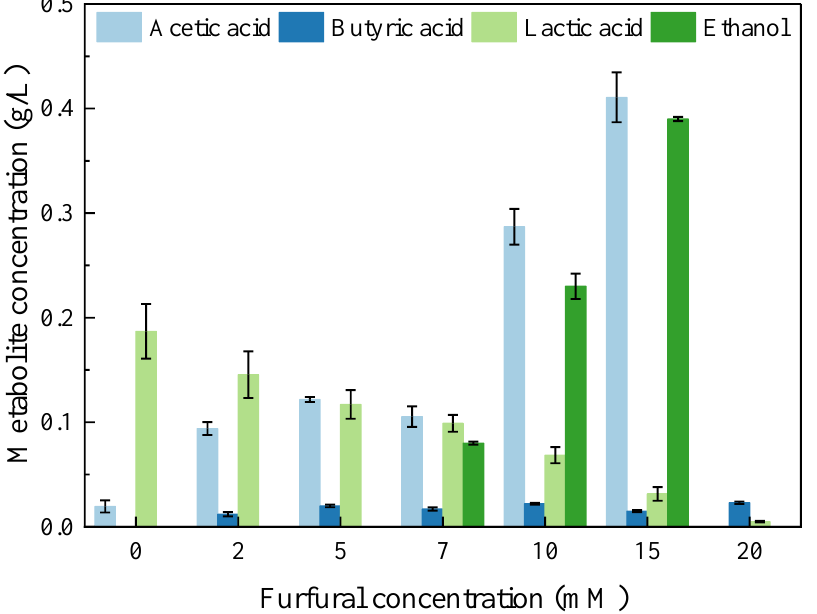
Figure 5. Effects of furfural concentration (0–20 mM) on the distribution of soluble metabolic products. Furfural can be decomposed into acetic acid in mixed anaerobic cultures, which may account for the increase in acetic acid [32]. Negligible butyric acid concentrations have been found at all furfural concentrations, including the control, and it is known that butyric acid is the substrate for hydrogen production. The above results suggested that butyric acid was formed by glucose degradation, which is reasonable, as few butyric acids were detected in the residual medium. Lactate was also found in all test conditions but showed the highest concentration at 0 mM furfural and the least at 20 mM furfural. In addition, ethanol concentration was up to 0.39 g/L with 15 mM furfural addition. High furfural concentration can lead to the overproduction and accumulation of inhibitory end-products like ethanol, resulting in obstruction or even elimination of the hydrogen production ability of bacteria